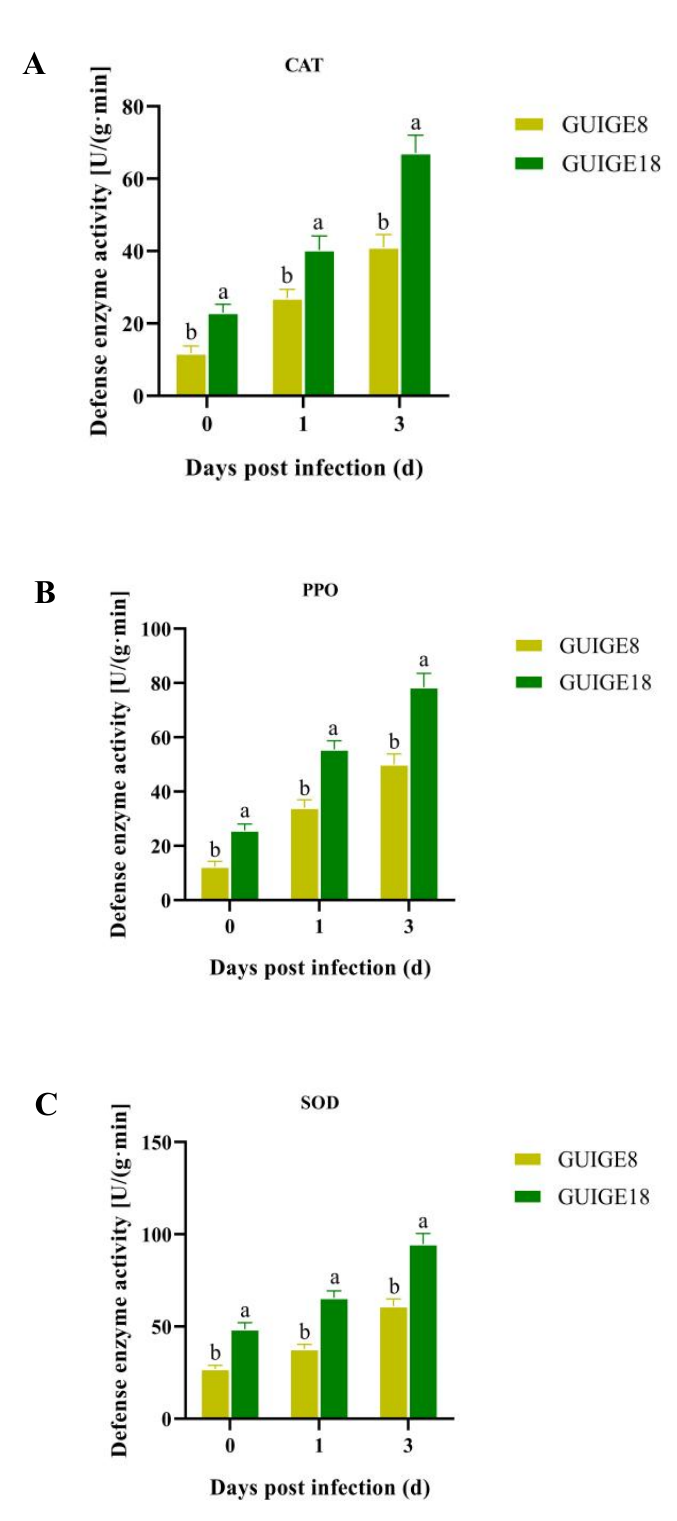
Figure 5. The activity of defense enzymes across three time points (0, 1 and 3 days) after SpM infection in resistant (GUIGE18) and susceptible cultivars (GUIGE8). ( A ) Catalase (CAT); ( B ) Polyphenol oxidase (PPO); and ( C ) Superoxide dismutase (SOD). Letters ‘a/b’ indicate difference changes between the two cultivars on the same day ( p < 0.05), according to Duncan’s multiple range test using SPSS software.